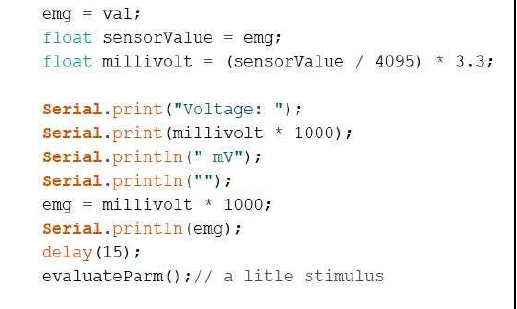
Figure 7. Code 6 — simulation of data acquired by electromyography sensor.